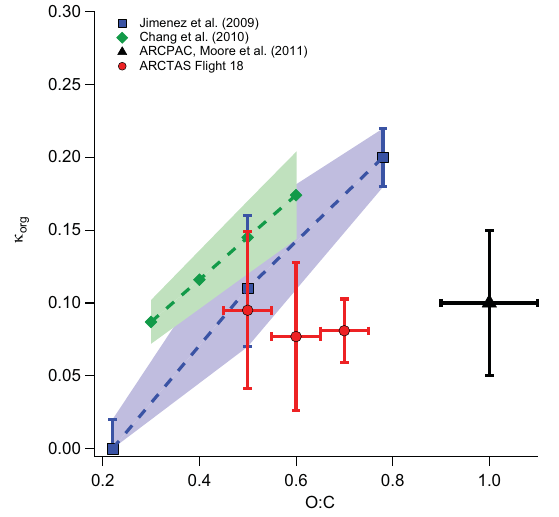
Fig. 7. Inferred κ org vs. HR-ToF-AMS derived O : C ratios. Mark- ers denote observed relationships published by Chang et al. (2010) in rural Egbert, Ontario, Canada (green) and Jimenez et al. (2009) for a variety of ambient and laboratory organic aerosols (blue). Shaded area represents the reported standard deviation from the mean. Black triangle represents the average values observed dur- ing the 2008 ARCPAC campaign for biomass burning influenced air masses (Moore et al., 2011). Red circles indicate average values ob- served for biomass burning plumes sampled during ARCTAS Flight